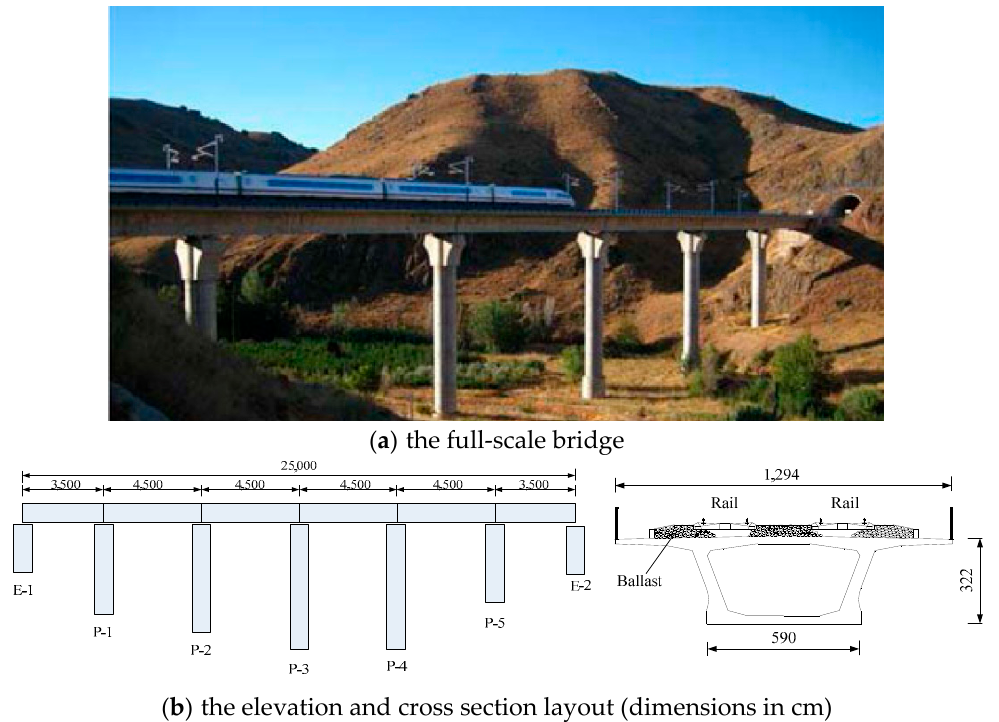
Figure 2. The Jalón viaduct: ( a ) the full-scale bridge; ( b ) the elevation and cross-section layout (dimensions in cm).